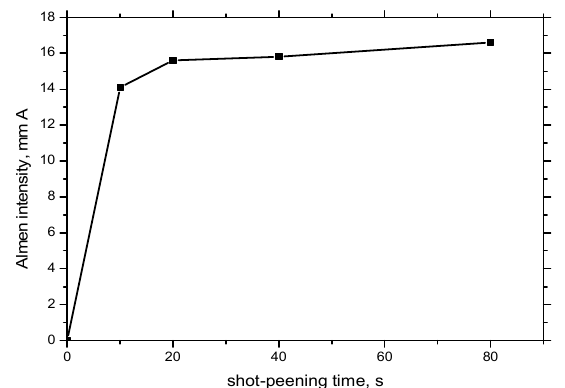
Table 1. Chemical composition of the AISI 1070 steel in wt%.